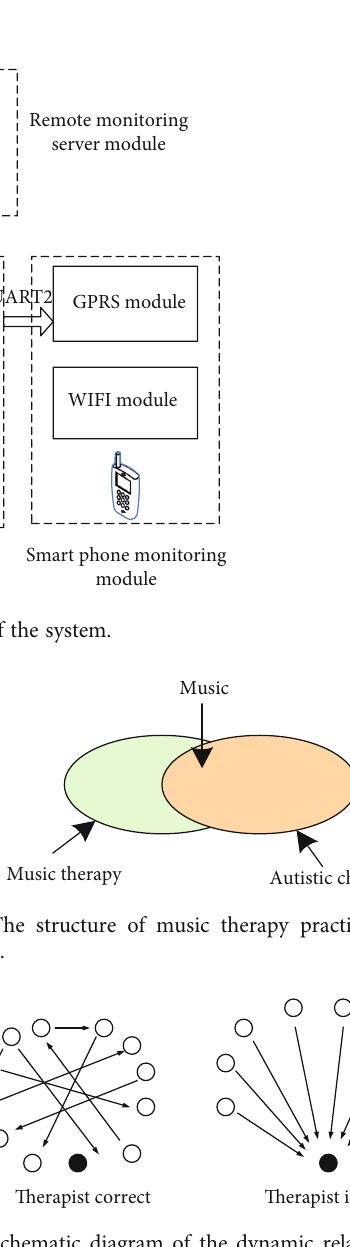
Figure 3: Schematic diagram of the dynamic relationship of the group therapy